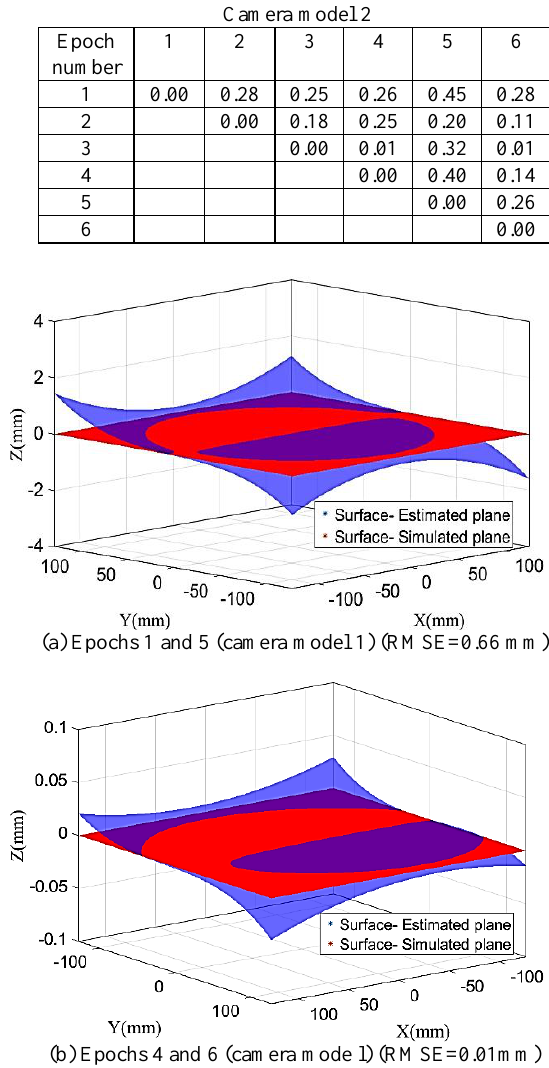
Table 5. RMSE of the 3D points differences (mm)